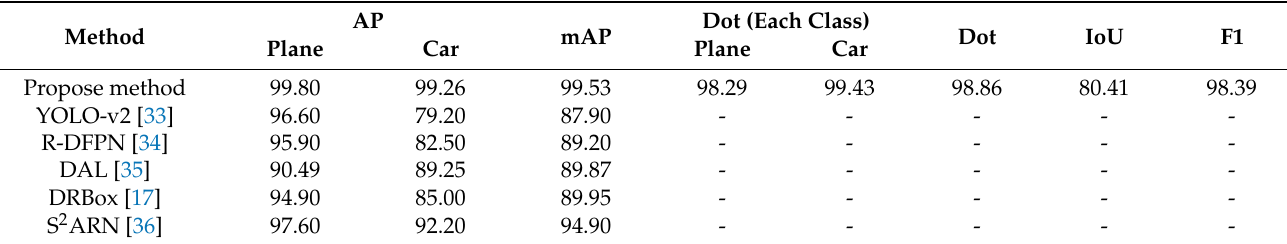
Table 5. The experimental results of the UCAS-AOD dataset.